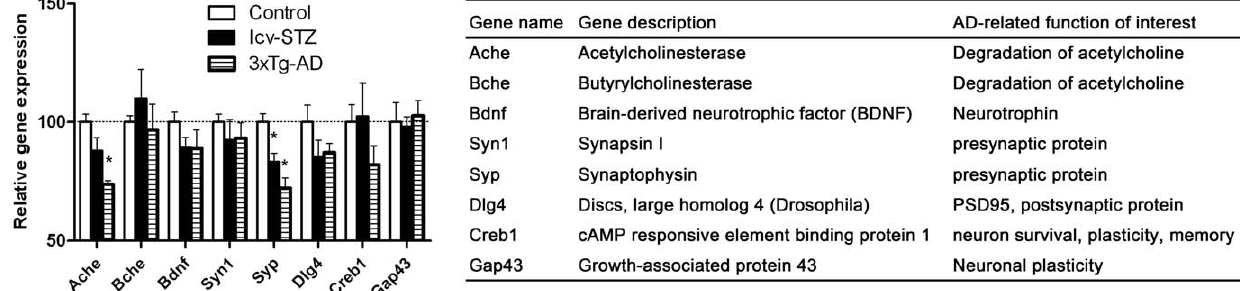
Figure 4. Synapse-related gene expressions in the hippocampus.